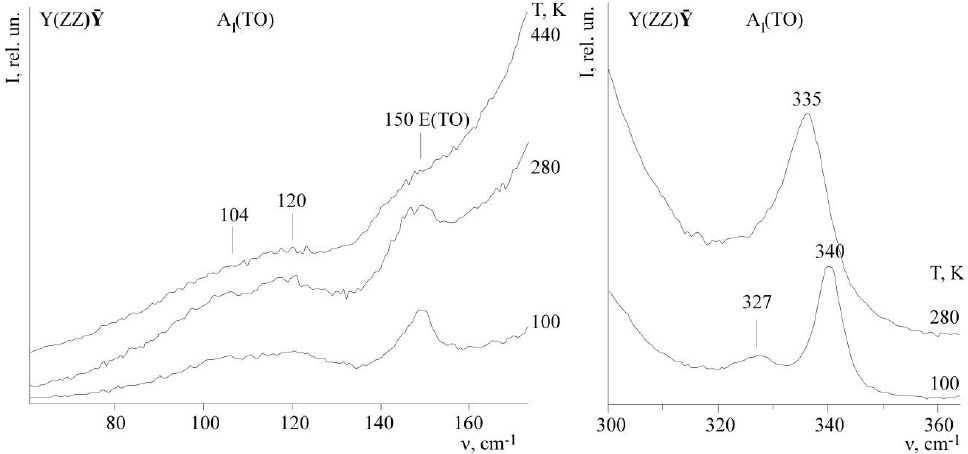
Figure 15. Fragments of the Raman spectrum of a CLN crystal in the region of 70 – 180 and 300 – 360 cm − 1 . Extra bands are marked with arrows. T = 100 K. The figure is reproduced with the permission of Pleiades Publishing, Ltd. from the paper Opt. Spectrosc. 2016, V. 121, P. 842 – 850. doi: 10.1134/S0030400X16120225.